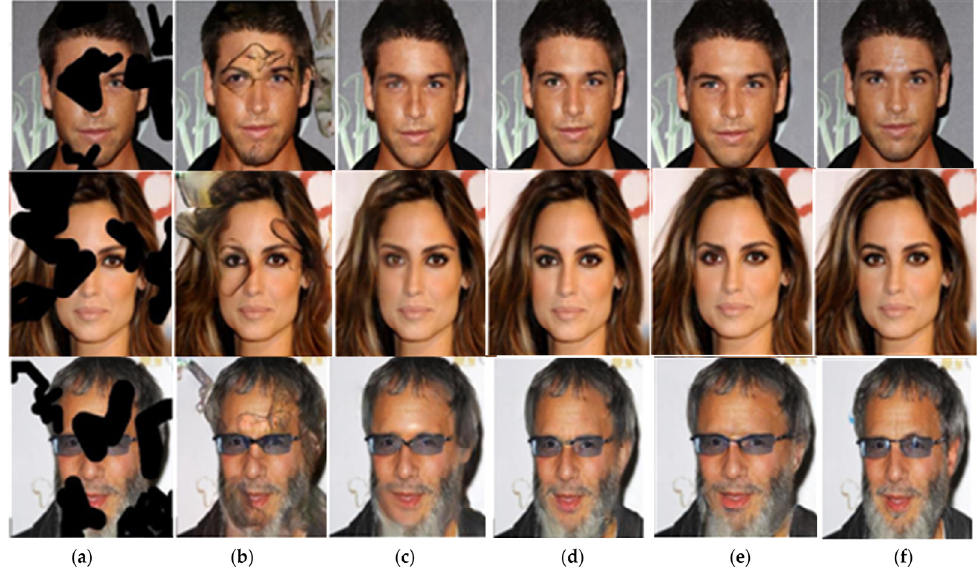
Figure 12. C omparison of di ff erent methods on the free-form masked images. ( a ) Input images of the network; ( b ) Results of CE; ( c ) Results of GCA; ( d ) Results of PEPSI; ( e ) Results of Ours; ( f ) Ground truth.